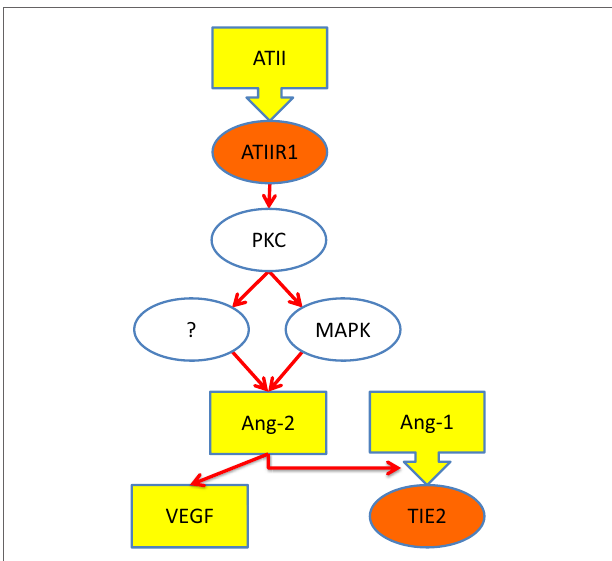
FigUre 6 | schematic representation of a proposed mechanism through which aTii leads to over-activation of Tie2 (see text) . Ligands (yellow), receptors (orange), and intracellular signaling (white). Abbreviations: ATII, angiotensin II; ATIIR1, angiotensin II receptor 1; PKC, protein kinase C; MAPK, mitogen-activated protein kinase; Ang-1, angiopoetin-1; Ang-2, angiopoetin-2; VEGF, vascular endothelial growth factor.